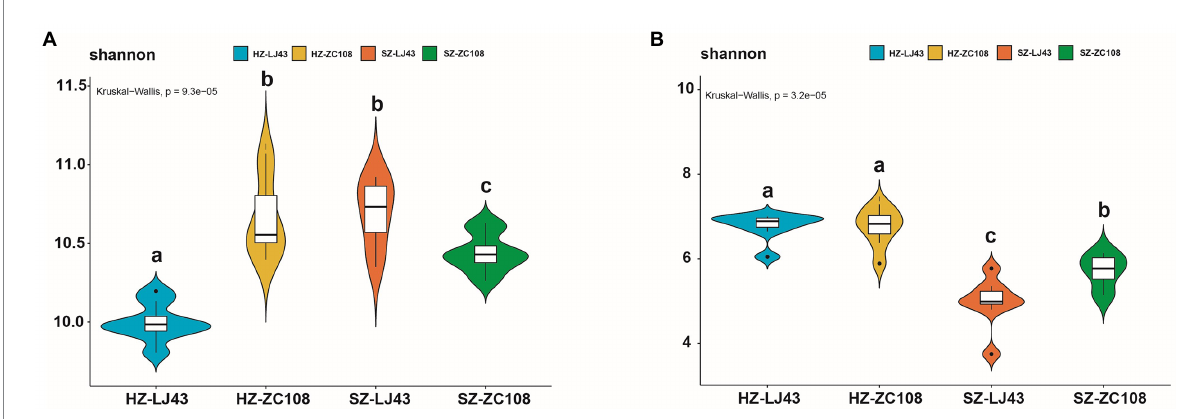
FIGURE 3 Alpha diversity ( α -diversity) estimated as Shannon index. (A) Bacteria, (B) Fungi.The horizontal lines represent the median. The tops and bottoms of boxes represent 75th and 25th quartiles, respectively. The upper and lower whiskers represent a 95% confidence interval. Mean values ± standard error ( n = 8); Different letters indicate a significant difference ( p < 0.05) based on one-way ANOVA followed by an LSD